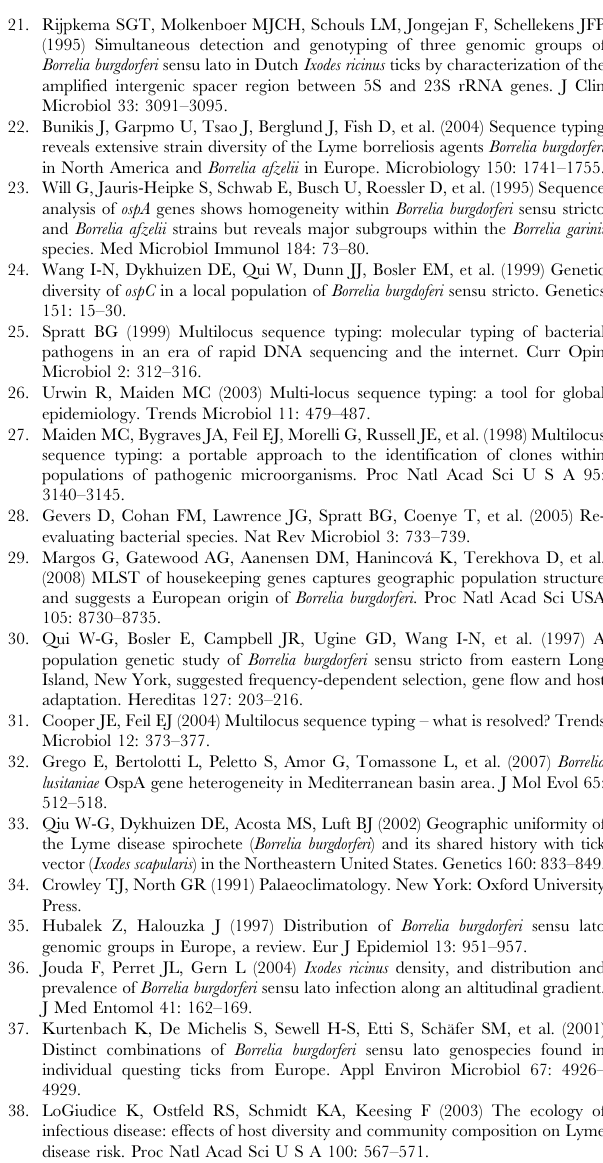
Figure S11 Analysis of MLST sequences with ClonalFrame software. The figure shows the inferred genealogy of STs. The numbers of STs correspond to numbers as shown in Table 2. The nodes are labelled with letters A to L. Figure S12 Probability plots for recombination. Each diagram corresponds to likely substitution/recombination events inferred on the branches above nodes C to L in Figure S11 (e.g. events on the branch above node C). For nodes A and B no diagram was obtained. The columns in each diagram correspond to each of the seven housekeeping gene fragments. The scale on the y axis ranging from 0 to 1 refers to the probability of recombination.